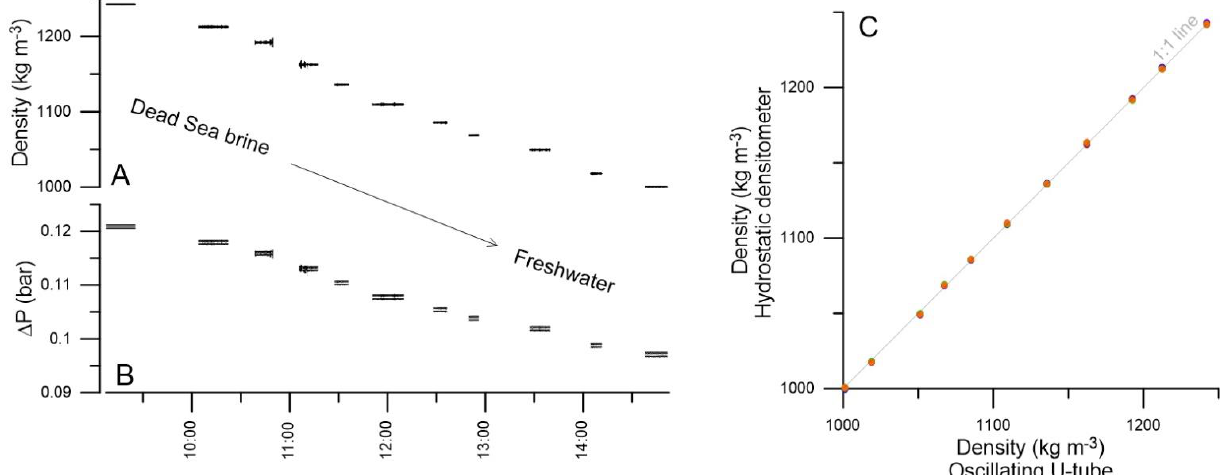
Figure 5. The hydrostatic densitometer laboratory experiment. The experiment lasted 6 h (24 May 2020), including 11 steps of water dilution from Dead Sea brine to distilled freshwater; the period of water mixing is excluded. The measured density and pressure difference for the nine pairs of pressure sensors presented in ( A ) and ( B ), respectively. ( C ) Measured density from the hydrostatic densitometer vs. the DMA 35 oscillating U-tube densitometer; the accuracy of the hydrostatic densitometer is confirmed by the close fit to the standard density measurement (1:1 line) with an R 2 value of